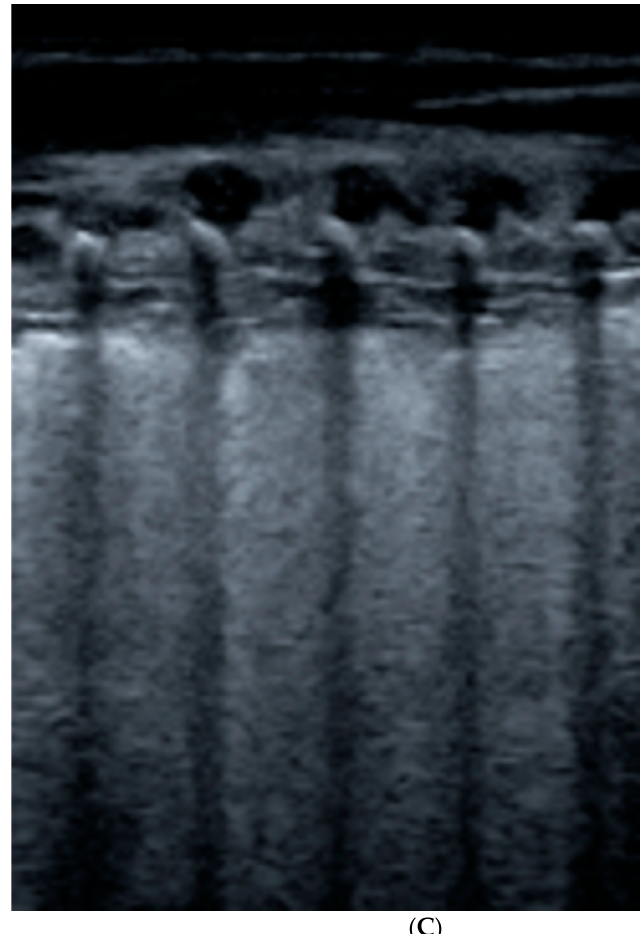
Figure 1. B-lines: vertical hyperechoic artifacts, extending from the pleura that erase normal A-lines (horizontal hyperechoic artifacts). They are the sign of increased interstitial fluid content and thickening of interlobular septae. ( A ) Deep B-lines, ( B ) short B-lines, ( C ) compact B-lines: the number of these artifacts is proportional to the decrease in air content with a tendency to confluence in severe alveolar–interstitial syndrome.